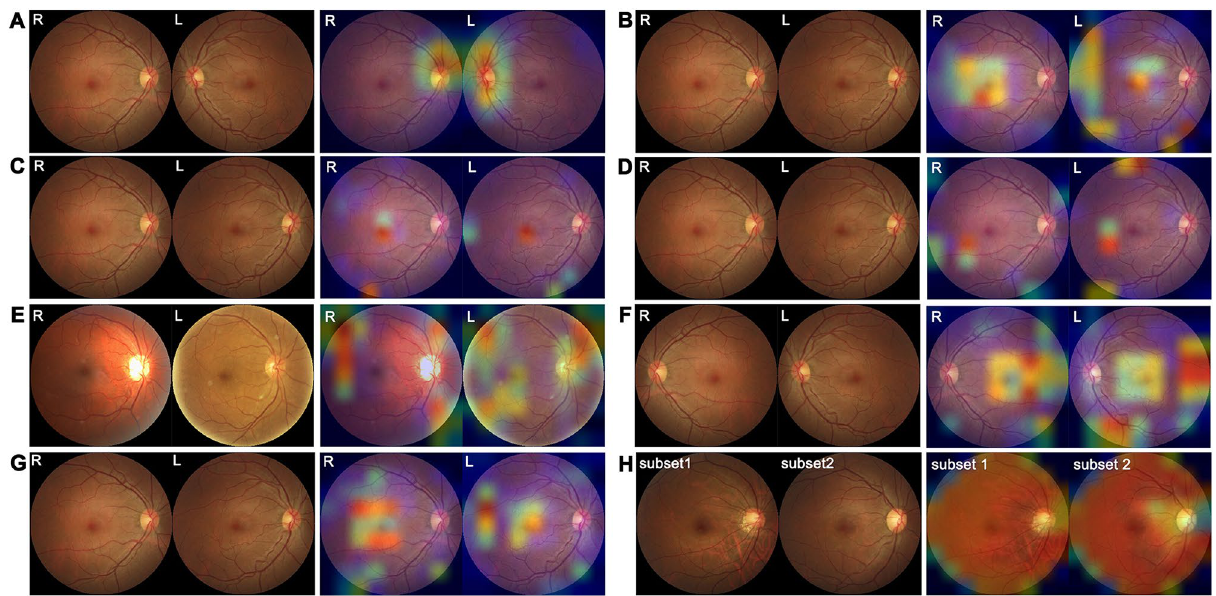
Figure 3. Image Sets with their corresponding class activation mapping (CAM) results. ( A ) Set 1 consisted of fundus images of right and left eyes. CAM highlighted the optic disc as the discriminative region. ( B ) Set 2 consisted of non-flipped right fundus images and flipped left fundus images. It was difficult to identify right and left images, but CAM highlighted the macula as the discriminative region. ( C,D ) The fundus photographs of Sets 3 and 4 were identical to Set 2 but used the ResNet50 and VGG19 models, respectively. CAM also highlighted the macula as the discriminative region. ( E ) Set 5 used the DenseNet121 model on the ODIR dataset. After left images were flipped, we tried to discriminate right images from left images. CAM highlighted not only the macula but also the superonasal and inferonasal retinal nerve fiber layer. ( F ) Set 6 consisted of flipped right fundus images and non-flipped left fundus images. The results were indistinguishable from those with Set 2. ( G ) Set 7 consisted of right fundus images flipped twice and left fundus images flipped once. CAM highlighted the macula as the discriminative region. ( H ) Set 8 consisted of images of only the left eye flipped once. As the entire image was highlighted in CAM, we could not specify the discriminative